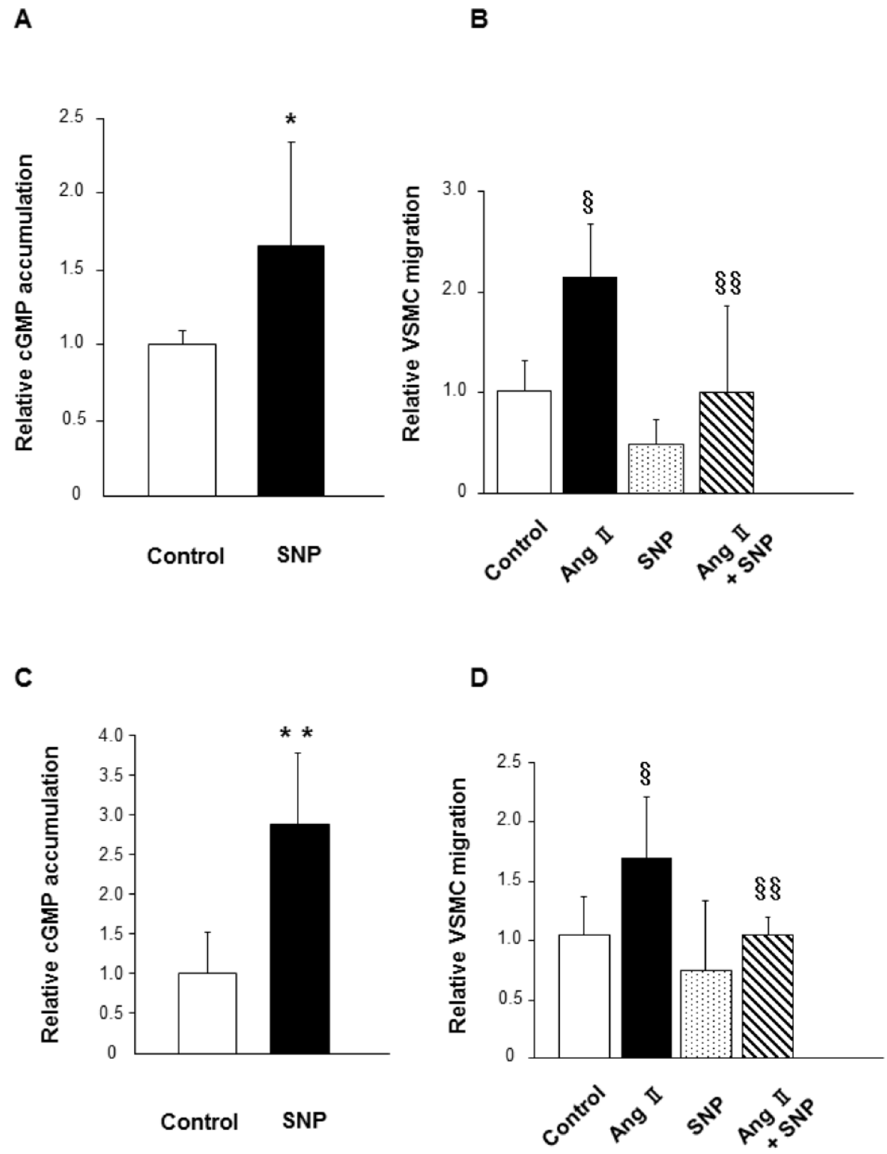
Figure 1. Effect of SNP on cGMP accumulation and cell migration in murine and human aortic VSMCs. (A) cGMP accumulation was evaluated after treatment with a vehicle or SNP (40 m mol/L) for 5 minutes in murine VSMCs. n=6 to 8 in each group. (B) Murine VSMCs migration was evaluated using a modified Boyden chamber assay after 24 hours of incubation with a vehicle or SNP (40 m mol/L) and/or Ang II (40 m mol/L). n=12 to 13 in each group. (C) cGMP accumulation was evaluated after treatment with a vehicle or SNP (40 m mol/L) for 5 minutes in human aortic VSMCs. n=5 to 7 in each group. (D) Human aortic VSMCs migration was evaluated using a modified Boyden chamber assay after 24 hours of incubation with a vehicle or SNP (40 m mol/L) and/or Ang II (40 m mol/L). n=12 in each group. *P , 0.05 compared to control; 1 P , 0.0001 compared to control; 11 P , 0.0001 compared to Ang II. **P , 0.01 compared to control.